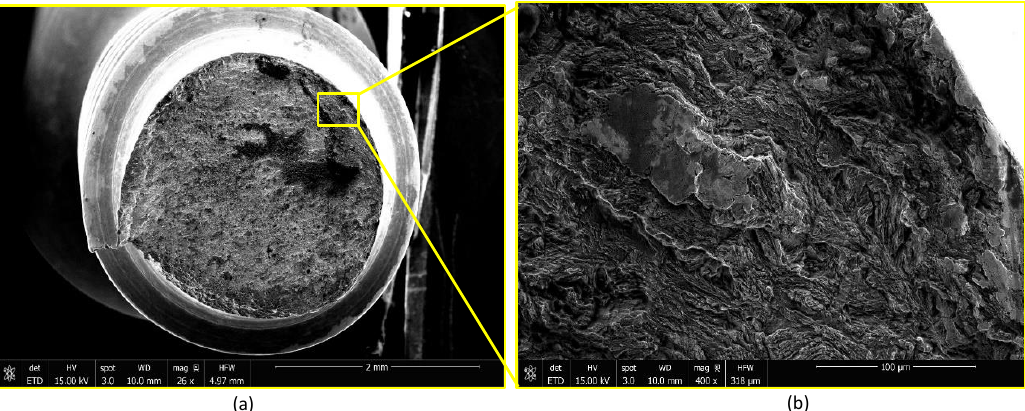
Figure A9. ( a ) Montage of SEM images showing the fracture surface of the cortical screw (CS4), ( b – d ) fatigue striations.